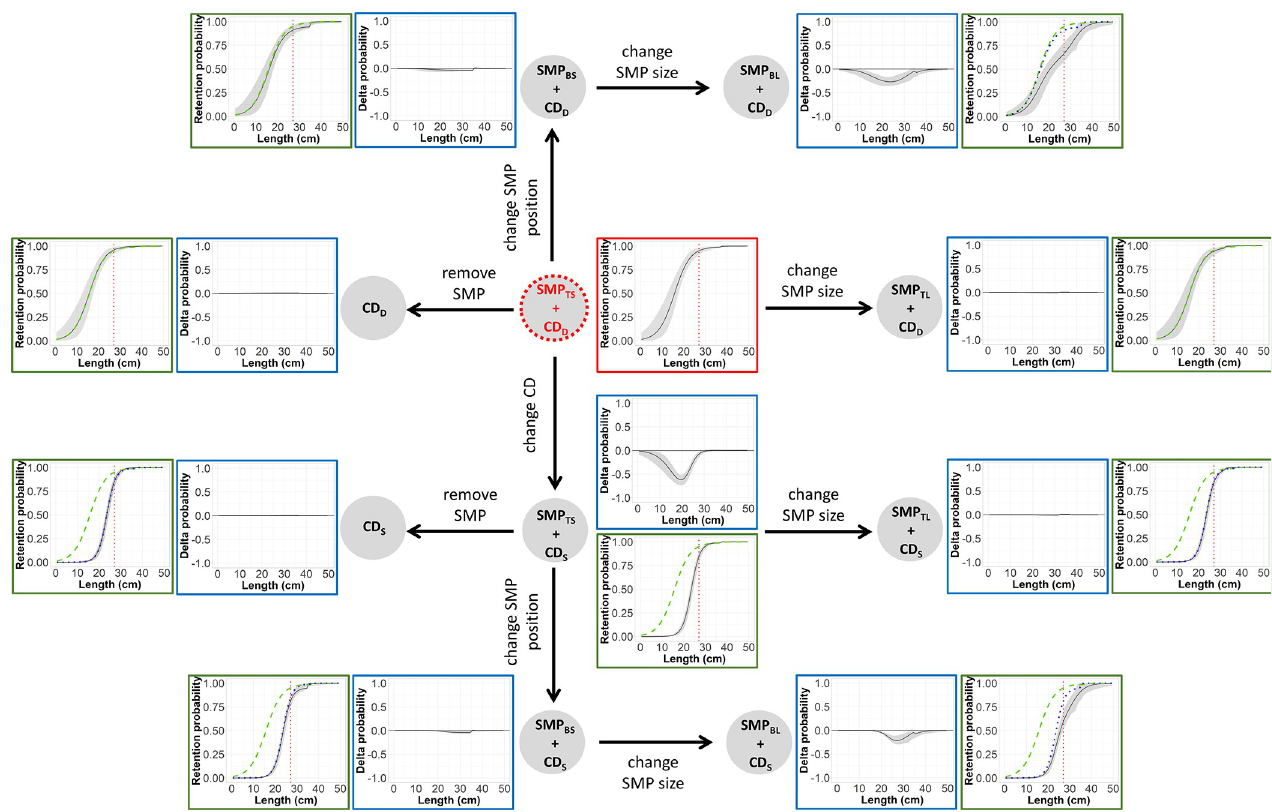
Fig 7. Size selection treatment tree for hake. Delta comparisons (blue boxes) carried out (represented by arrows), which include delta curves for each modification applied in the gear (black line) with its corresponding CIs (grey bands), are shown. Each step also includes selectivity plots (green boxes) showing: selection curves for the treatment gear design (black line) with CIs, baseline gear design (blue dots) and reference gear design (green dashed lines). Vertical red dotted lines correspond to the MCRS: 27 cm.